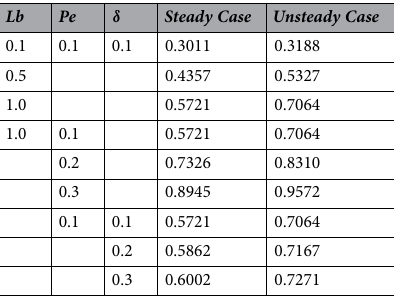
Table 7. Results of motile density number – χ ′ ( 0 ) for various